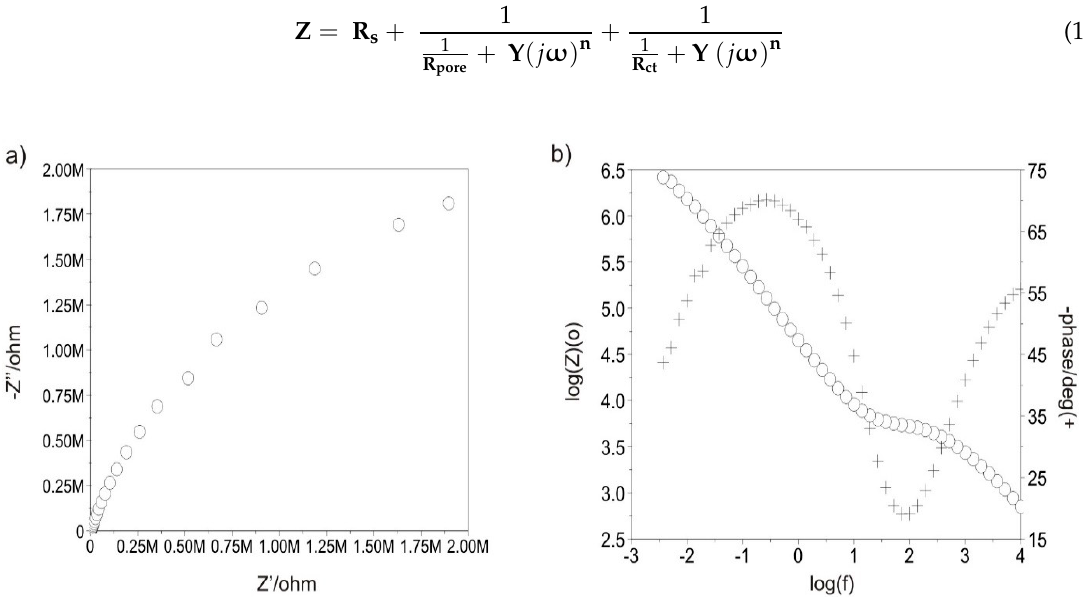
Figure 11. Polished sample with the DLC coating: ( a ) Nyquist diagram ( b ) Bode diagram. ◦ : log(Z); + : -phase/deg.